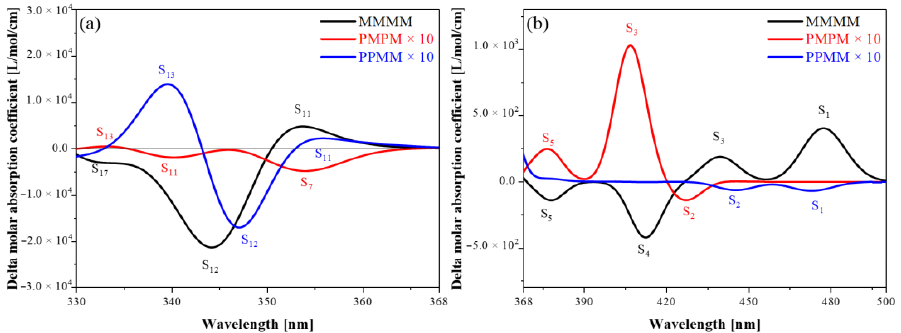
Figure 7. The ECD of three isomeric molecules. The black line represents the ECD of the asymmetric isomer (MMMM), the red line indicates the ECD of the symmetric diastereomer (PMPM) expanded by 10 times and the blue line represents the ECD of the symmetric diastereomer (PPMM) expanded by a factor of 10. ( a ) The ECD of three isomeric molecules at 330–368 nm. Where, the black peaks correspond to S11, S12, and S17 of MMMM, the red peaks correspond to S7, S11, and S13 of PMPM, and the blue peaks correspond to S11, S12, and S13 of PPMM, respectively; ( b ) the ECD of three isomeric molecules at 368–500 nm. Where, the black peaks correspond to S1, S3, S4 and S5 of MMMM, the red peaks correspond to S2, S3, and S5 of PMPM, and the blue peaks correspond to S1 and S2 of PPMM, respectively.